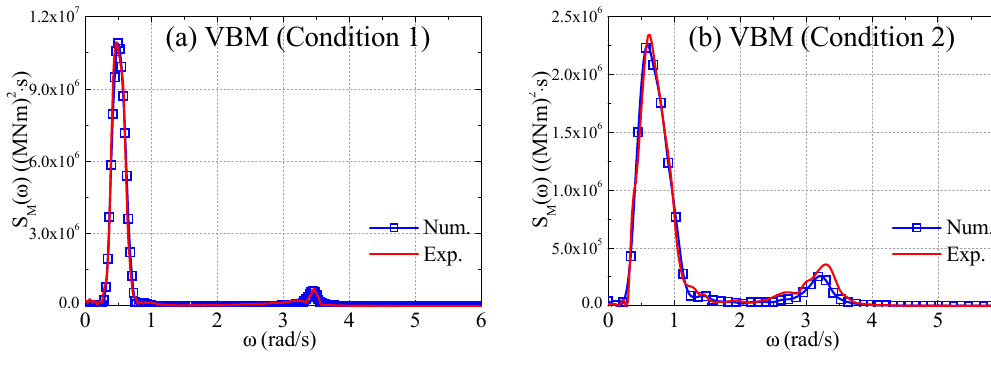
Figure 9. Comparison of heave spectra.